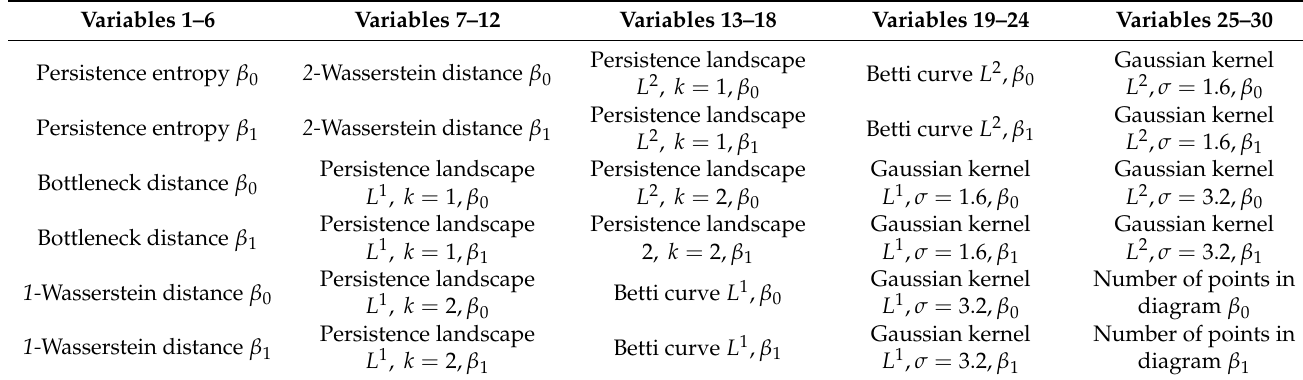
Table 1. List of the 30 topological indicators calculated per image.